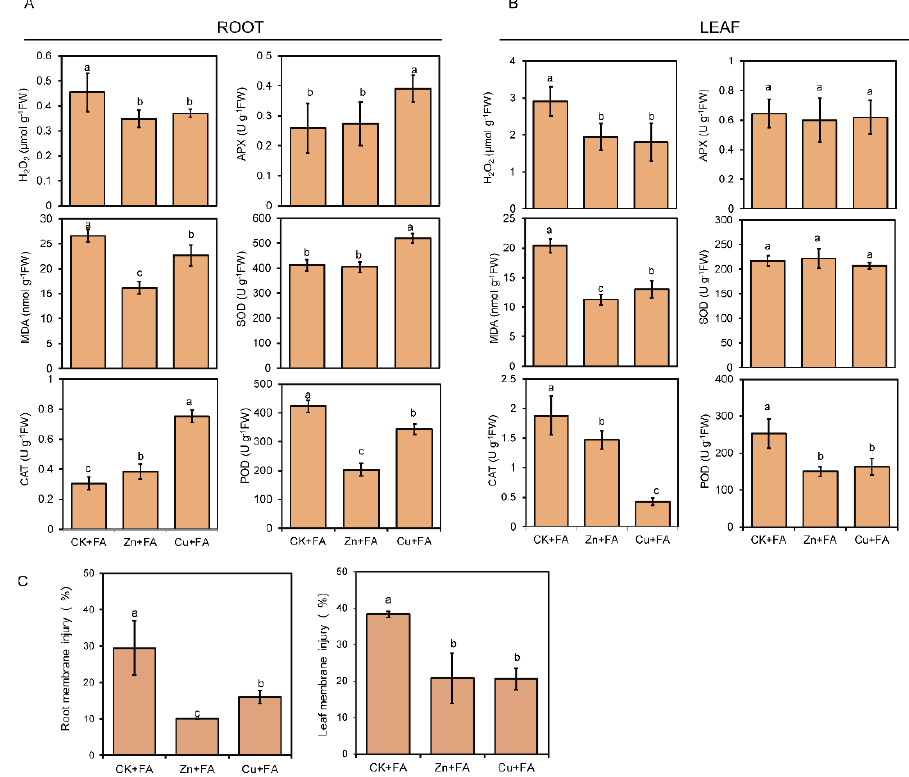
Figure 5. Effects of Zn or Cu on FA elicited ROS and cell membrane injury mitigation in leaf and root. The root ( A ) and leaf ( B ) H 2 O 2 , MDA and antioxidant enzyme activity levels were determined after treatment with FA for 72 h. ( C ) Relative membrane injury in the root and leaf. Bars represent standard deviation with four replications each. Different letters above bars indicate significant differences ( p < 0.05, Duncan’s multiple range test) among different treatments.